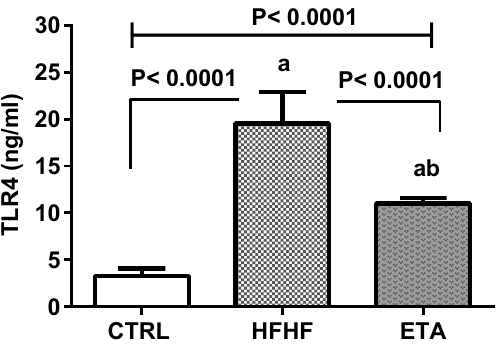
Figure 5. ETA reduces hepatic TLR4 concentrations. Comparison data from the HFHF-fed rats and standard chow-fed rats (CTRL) are shown. Data are presented as the mean ± SD values and are representative of a single independent experiment ( n = 6). Statistical analysis was performed using one-way ANOVA, followed by Tukey’s multiple comparison tests. a Significantly different from the normal control group. b Significantly different from the HFHF group. Differences were considered significant if the p-value was < 0.05. CTRL control, ETA etanercept, HFHF high-fat high-fructose diet, TLR4 Toll-like receptor 4.